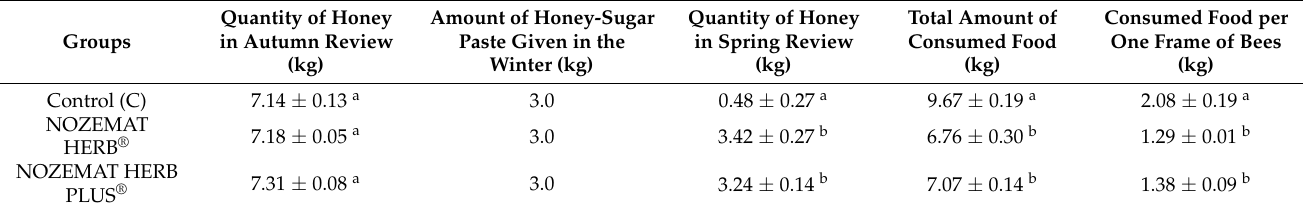
Table 3. Overwintering food consumption from the bee